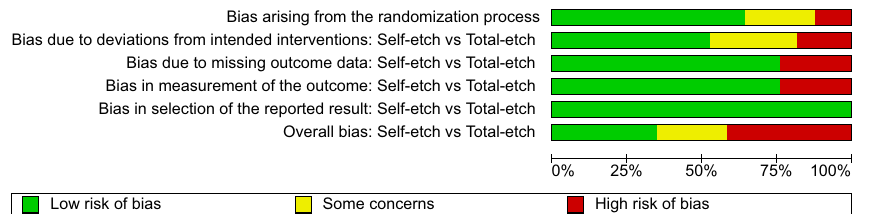
Fig. 4 General Characteristics of included studies. Distribution of gender, adhesive, evaluation criteria, Isolation method, follow-up and Sample size among various included studies.